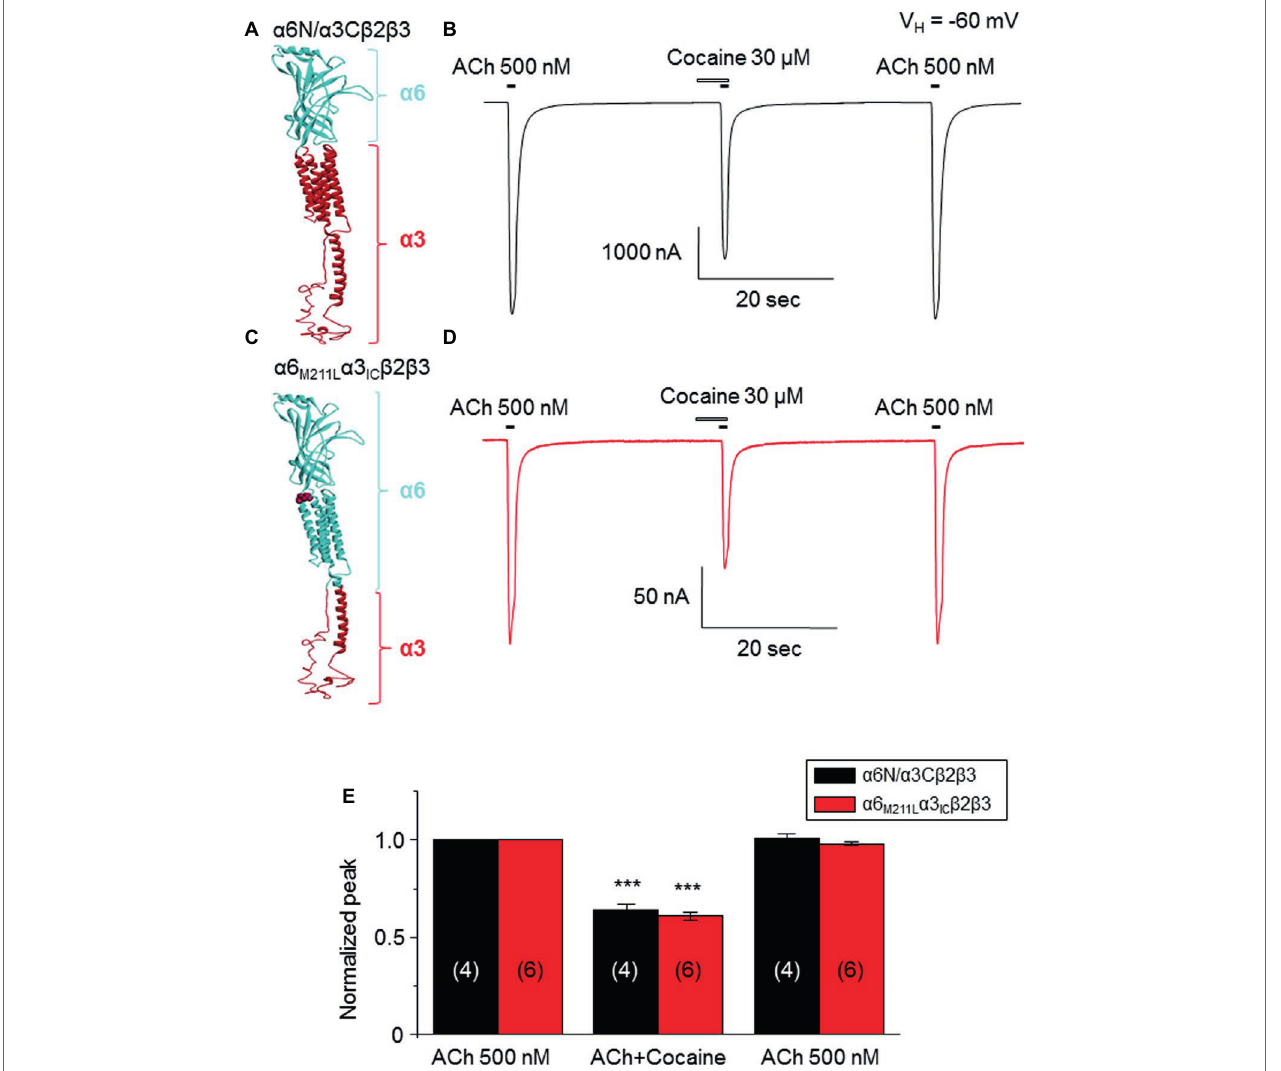
FIGURE 7 | Cocaine inhibits two types of α 6*-nAChR-mediated currents in Xenopus oocytes. (A) 3D structure of the α 6N α 3C subunit, which is similar to the heterologously transfected α 6/ α 3 chimera in human EH-EP1 cells. (B) Cocaine inhibited ACh-induced current in the α 6N/ α 3C β 2 β 3-nAChR. (C) 3D structure of the α 6 M211F α 3 IC subunit, which contains more content (N-terminal and four transmembrane domains) of α 6 subunit. (D) Acute cocaine effect on the α 6 M211L α 3 IC β 2 β 3 nAChR. (E) Statistical comparison of cocaine’s effect on α 6N α 3C β 2 β 3 nAChR- and α 6 M211F α 3 IC β 2 β 3 nAChR-mediated currents, with the similar inhibitory rate. *** p < 0.001 (paired t -test) when cocaine effect is compared to the control.